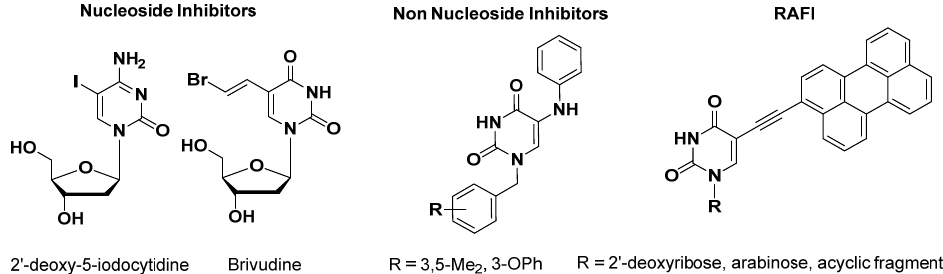
Figure 1. 5-Substituted pyrimidine analogues with different types of antiviral activity.